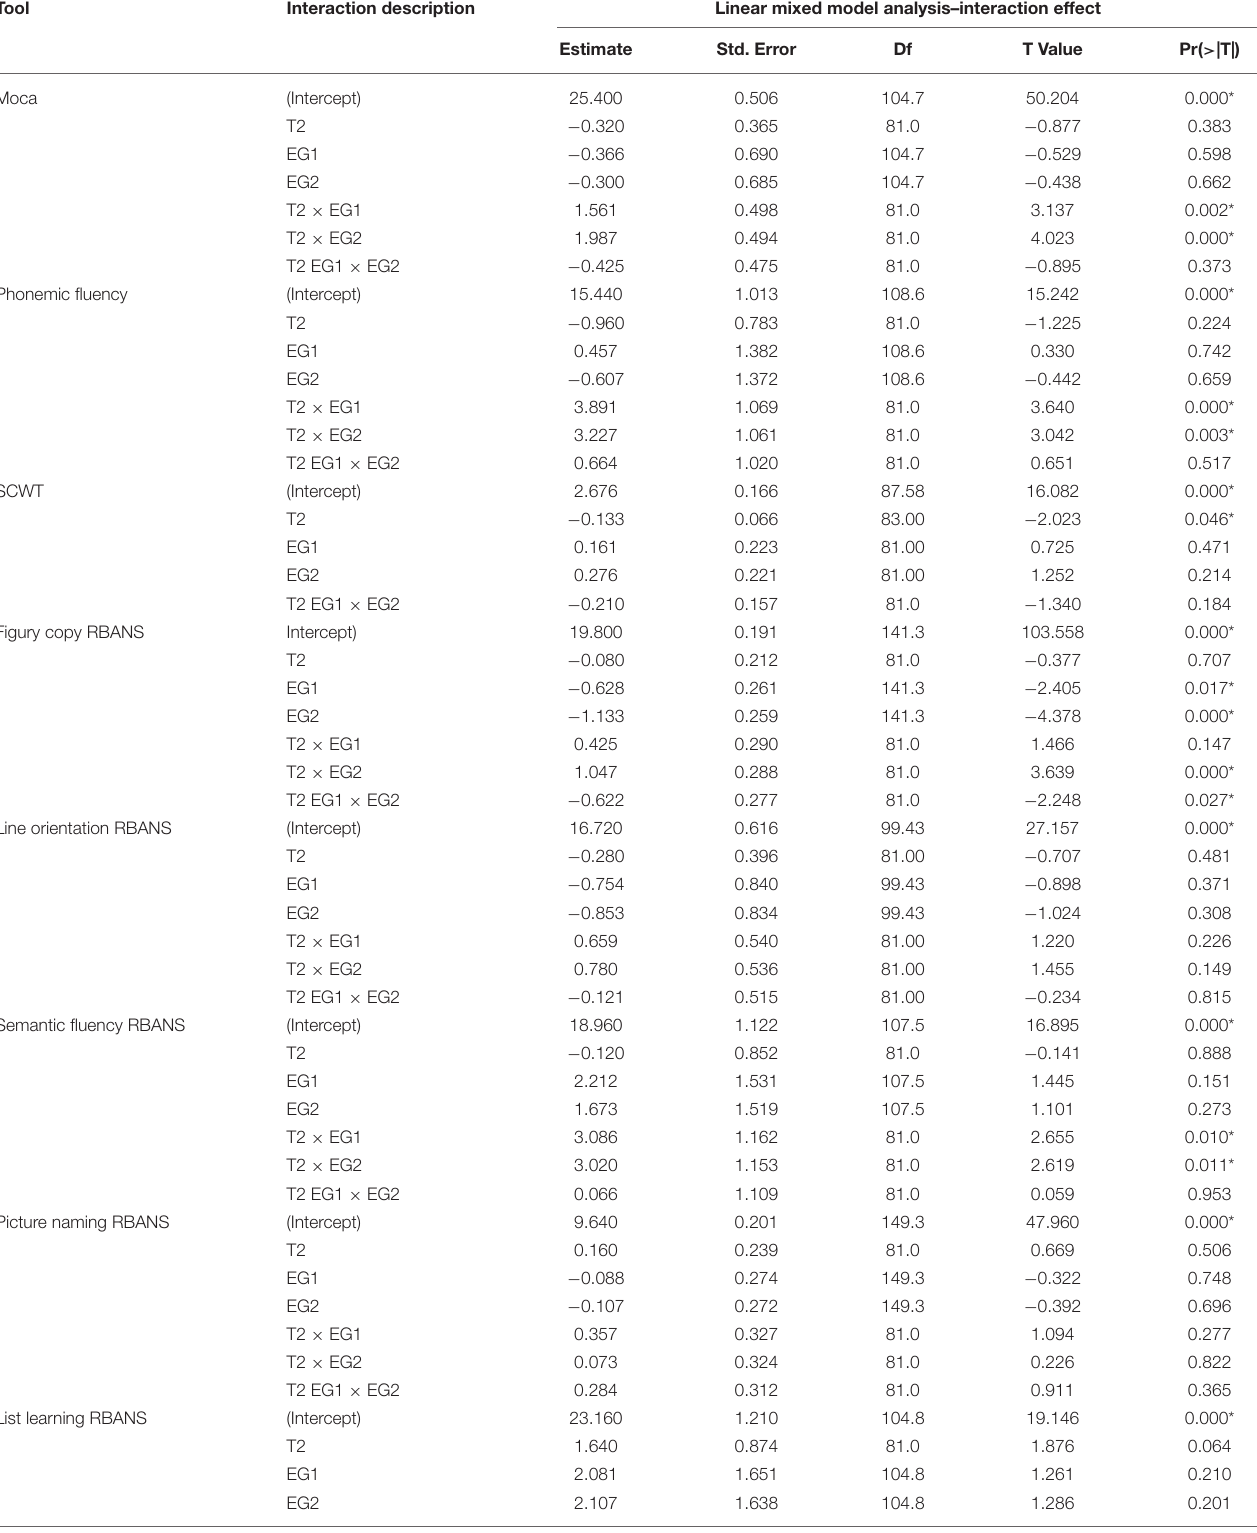
TABLE 3 | Linear mixed model analysis results (T1, T2).